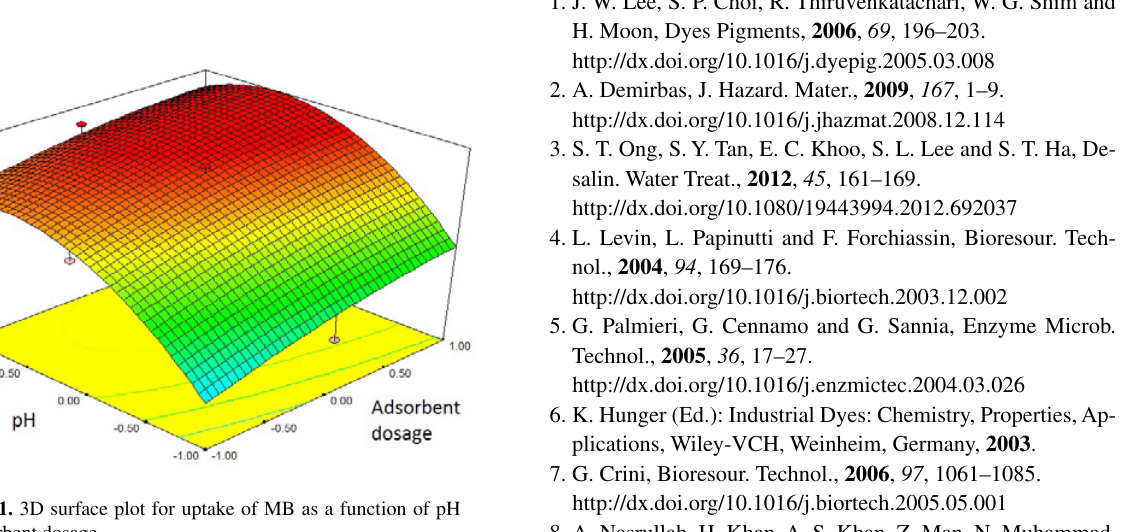
Figure 11. 3D surface plot for uptake of MB as a function of pH and adsorbent